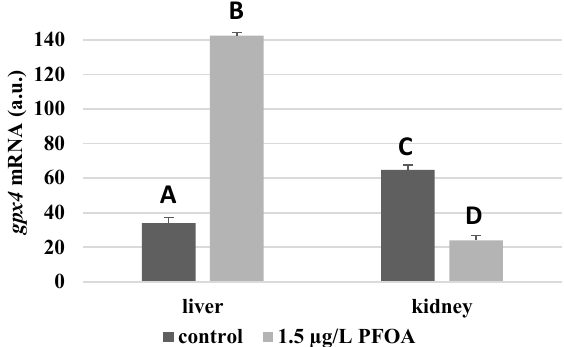
Figure 4. gpx4 mRNA expression levels in the liver and kidney of T. newnesi exposed to PFOA and unexposed (the control group). Values (arbitrary units) are indicated as mean ± SD. Transcription levels were normalized to the gapdh housekeeping gene. Different letters correspond to significant statistical differences ( p < 0.05) among different means (Student–Newman–Keuls test), with ten specimens per experimental group.